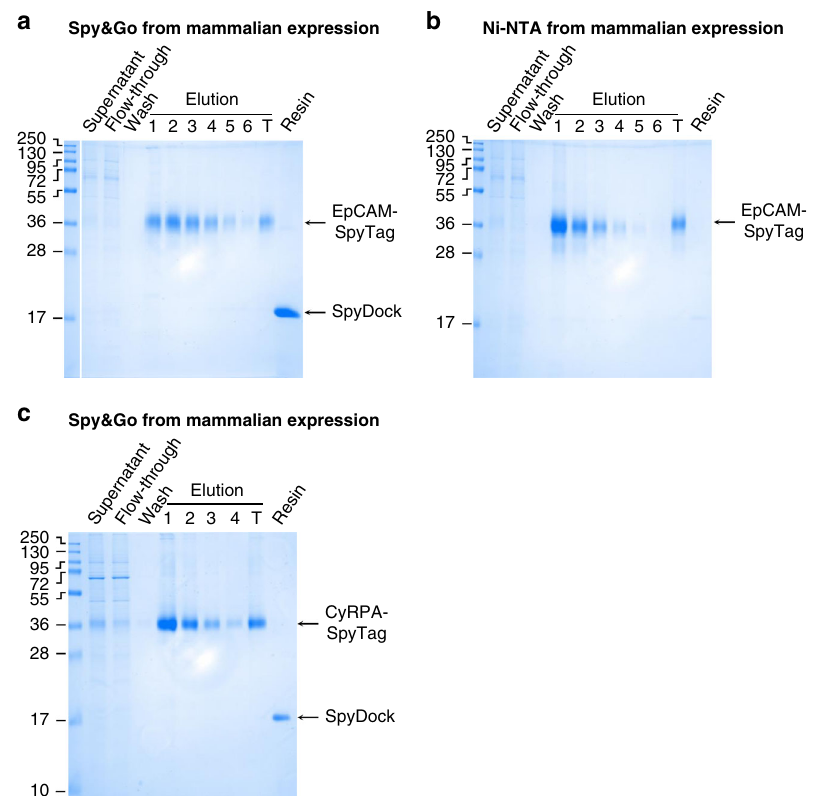
Fig. 5 Spy&Go from mammalian expression. a HEK293T cells were transfected with the extracellular region of EpCAM fused to SpyTag and a His-tag (EpCAM-SpyTag). EpCAM-SpyTag was puri fi ed from the clari fi ed cell supernatant using Spy&Go. Fractions were analyzed by SDS-PAGE with Coomassie staining. T: total pooled elutions. Resin: resin post-elution. b Ni-NTA puri fi cation of EpCAM-SpyTag as in a . c Spy&Go puri fi cation of CyRPA-SpyTag from Expi293HEK cells as in